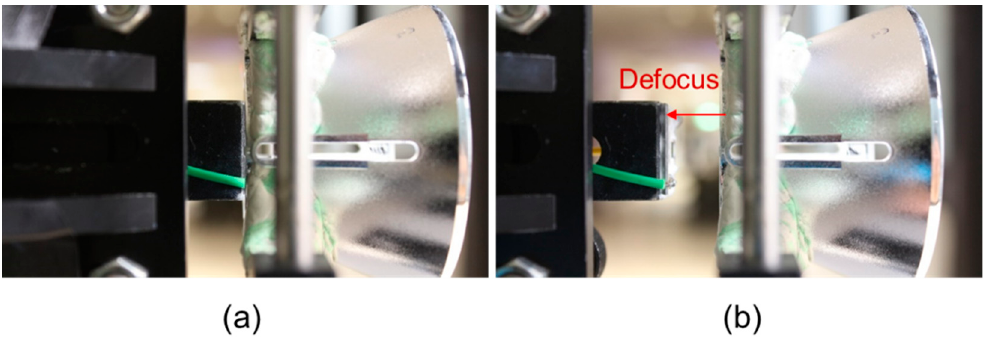
Figure 7. Distance between the pcW-LED and reflector was adjusted when ( a ) the pcW-LED was at the designed position and ( b ) departed from the position in ( a ).